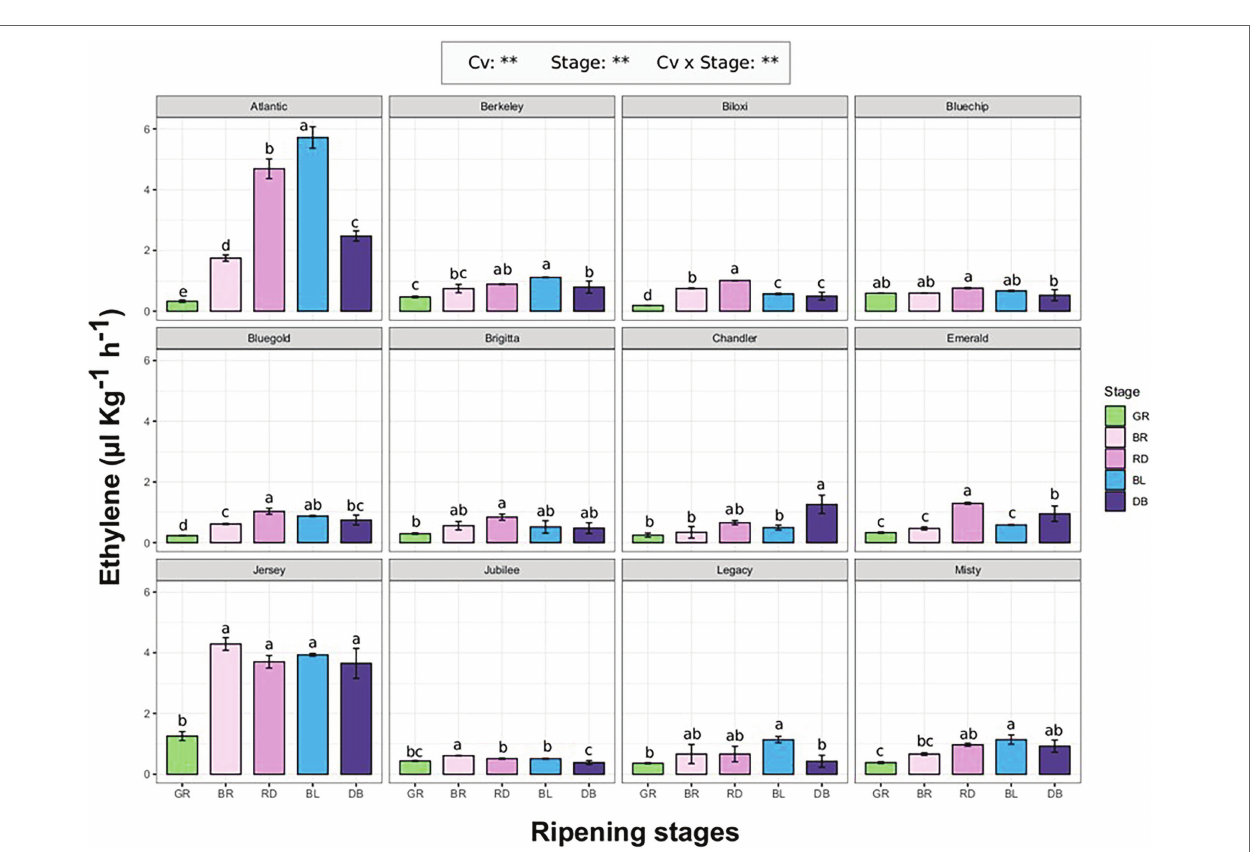
FIGURE 1 | Ethylene production rate of 12 blueberry cultivars assessed at five fruit ripening stages: green (Gr), breaker (Br), red (Rd), blue (Bl), and dark-blue (DB). Each measurement was done in four biological replicates. Ethylene measurement was assessed on intact berries by using an PTR/SRI-ToF-MS set in O 2+ mode. ANOVA levels of significance ( p < 0.05 and p < 0.01) are represented by * and ** , respectively. Different letters indicate significant differences between treatments ( p ≤ 0.05) according to Tukey ʼ s post-hoc